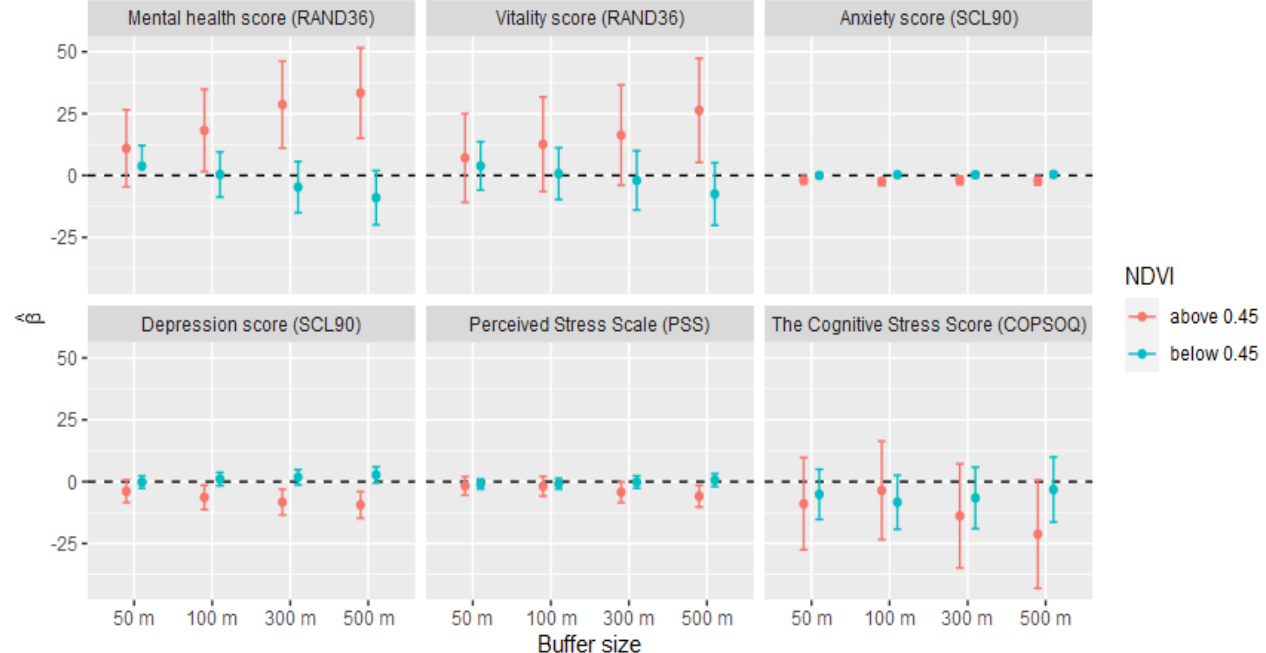
Figure 2. Mental health estimates associated with NDVI within different buffer sizes (models adjusted as in Table 6). Fully adjusted linear spline models with the knot set to NDVI = 0.45 (95% CI).